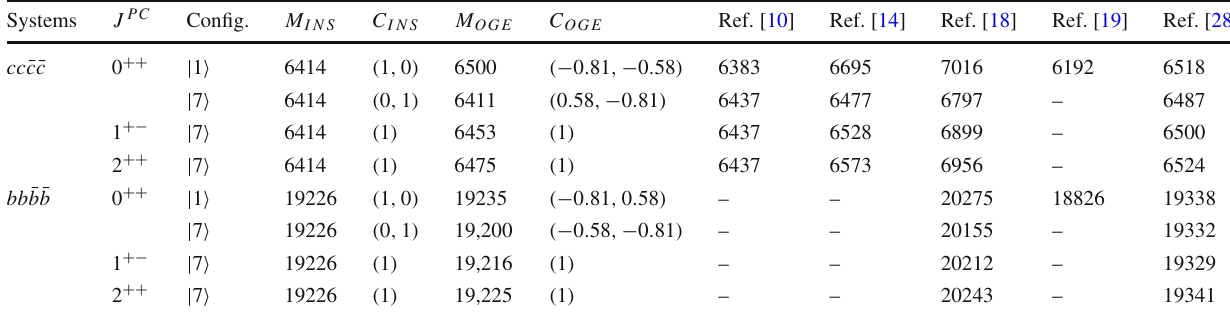
Table 4 The numerical results of spectrum for the S -wave cc ¯ c ¯ c and bb ¯ b ¯ b tetraquark states, where the columns M INS and M OGE show the numerical results of the obtained energies in unit of MeV empoying the INSandOGEmodels,respectively,oneshouldnotethattheeigenvalues are obtained by taking into account effects of the configurations mixing,